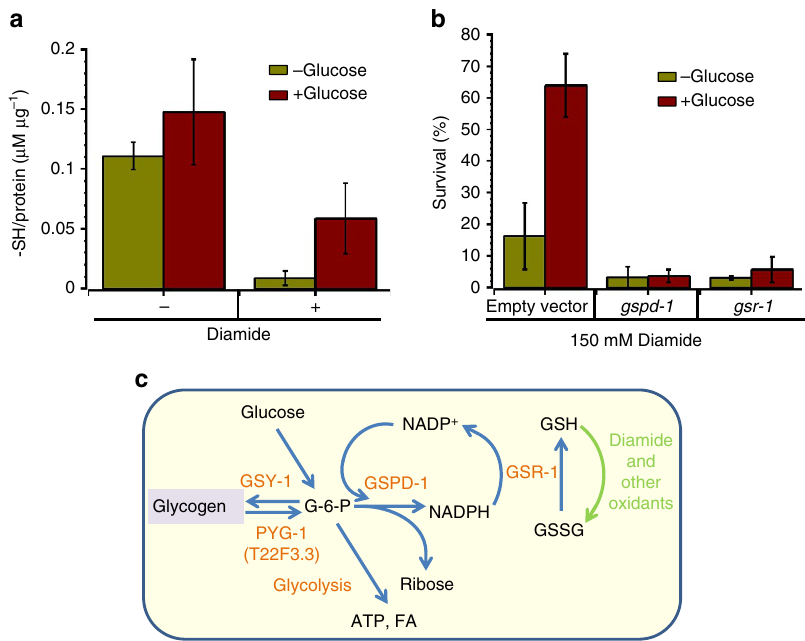
Figure 2 | Glucose-driven glutathione reduction is the major defense against oxidants. ( a ) Glucose promotes cellular thiols reduction. L4 worms were placed on NGM plates with or without glucose. Two-day-old adults were picked and incubated for 10min with ( n ¼ 400, P ¼ 0.035) or without ( n ¼ 400, P ¼ 0.13) non-lethal concentration of diamide. Total cellular reduced thiols were quantified in worm lysates by reaction with DTNB (see Methods section) Graph shows the mean ± s.e. from four independent experiments. ( b ) Endogenous glutathione is the major defense against oxidants. Glutathione reductase ( gsr-1 ) or glucose-6-phosphat dehydrogenase ( gspd-1 ) were knocked down by RNAi, followed by diamide treatment as in Fig. 1a. Graph shows the mean ± s.d. from at least three independent experiments (e.v.: n ¼ 140, P ¼ 0.0003; gsr-1 : n ¼ 120, P ¼ 0.129; gspd-1 : n ¼ 110, P ¼ 0.434). P values were calculated with respect to control animals in the same experiment using Student’s t-Test. See also Supplementary Fig. 1. ( c ) Major pathways of glucose utilization and storage. Upon entering the cell, glucose is phosphorylated and is utilized for ATP production and the biosynthesis of macromolecules. Excess glucose is stored as glycogen or converted to fatty acids (FA). A large portion of glucose is used for NADP þ reduction, which is required for